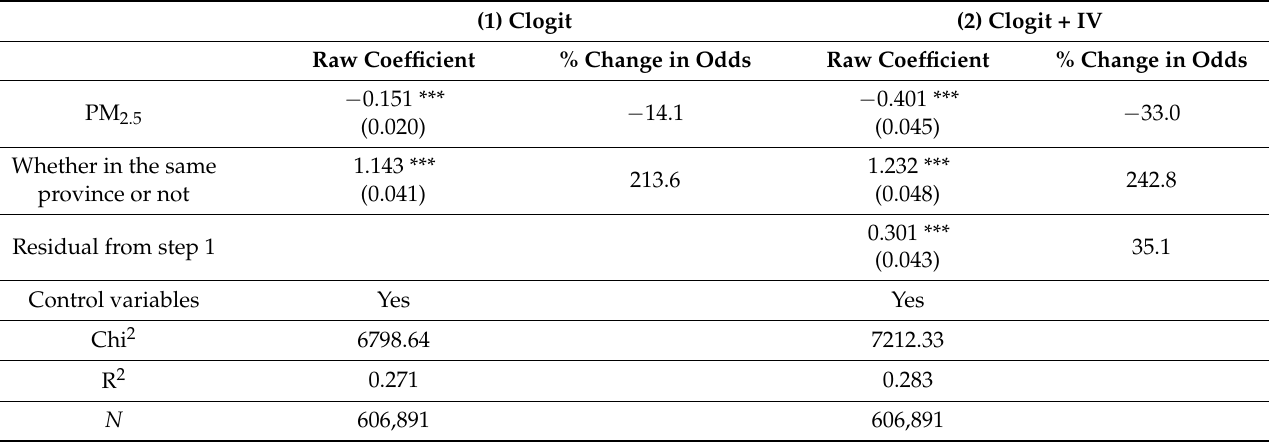
Table 5. Robustness check 2: the impact of